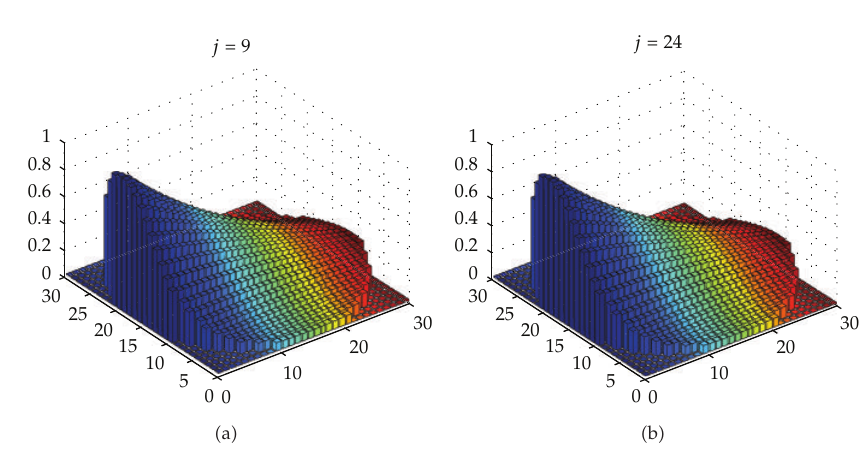
Figure 7: Given and reconstructed view 24 angular test flux in the model.